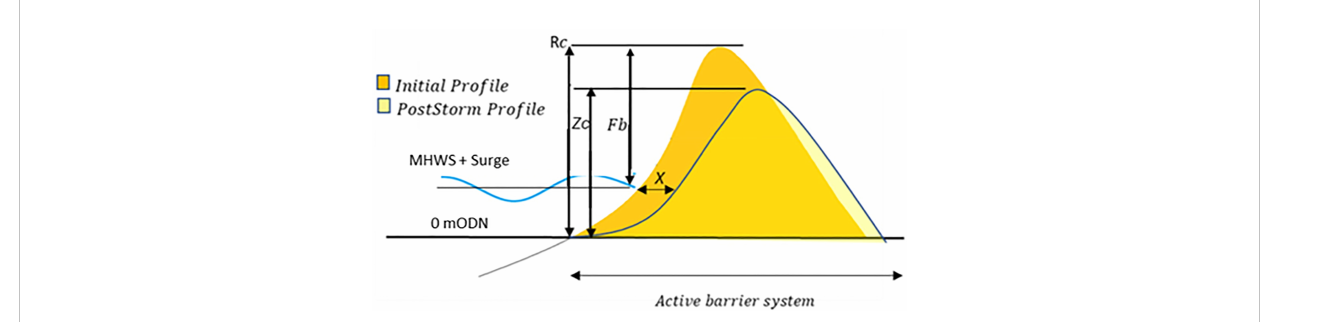
FIGURE 4 Schematic diagram for barrier parameter description. Barrier Freeboard, F b , which is the vertical height from the MHWS+ Storm surge to the barrier maximum crest height. R c is the pre-storm crest height above 0 mODN. Z c is the post-storm barrier crest height above 0 mODN; and X is the horizontal movement of the of barrier at